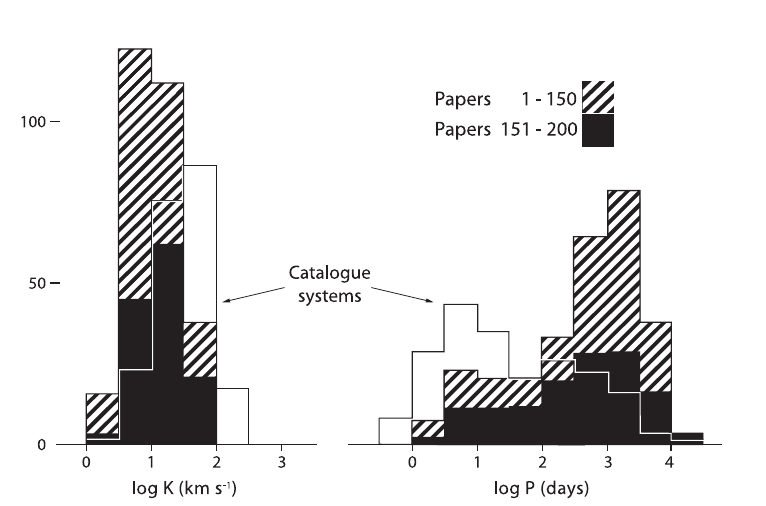
Figure 1. What was believed to be sure knowledge regarding the distribution of amplitudes ( K , left) and periods ( P , right) for tolerably-well determined binary-star orbits listed in the Seventh Catalogue of the Orbital Elements of Spectroscopic Binary Systems [2] (no in-filling) has been substantially altered simply by measuring enough radial velocities over a considerably longer time-span than was customary. Gri ffi n’s Papers 1–200 [1] containing the analyses were published at intervals of 2 months. The distributions of K and P are markedly di ff erent when the base-line is increased to (a) 25 years (cross-hatching) and (b) 33 years (black). The changes will have had a non-negligible influence on theories of binary-star formation. ( Reproduced by kind permission of Observatory Magazine.